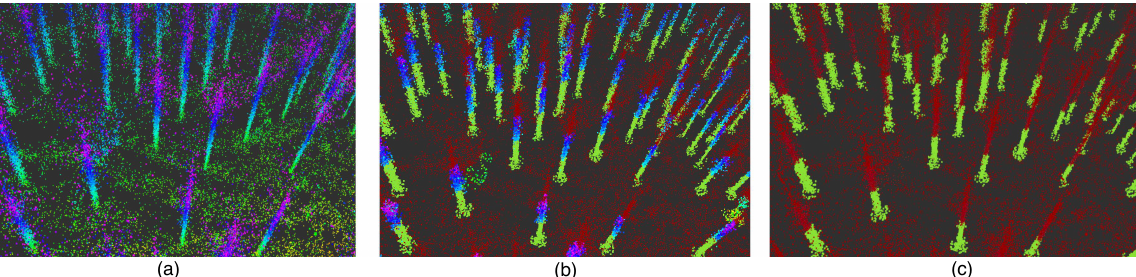
Figure 5. Trunk point cloud segmentation approach. ( a ) The original point cloud map. ( b ) The extracted trunk point cloud (blue and green) after removing ground and branch point cloud (red). ( c ) The final extracted trunk point cloud (green) after clustering